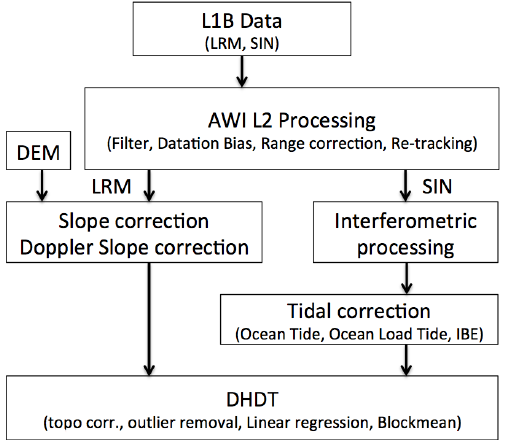
Figure 4. Sketch of the processing scheme used to derive the final d h /d t